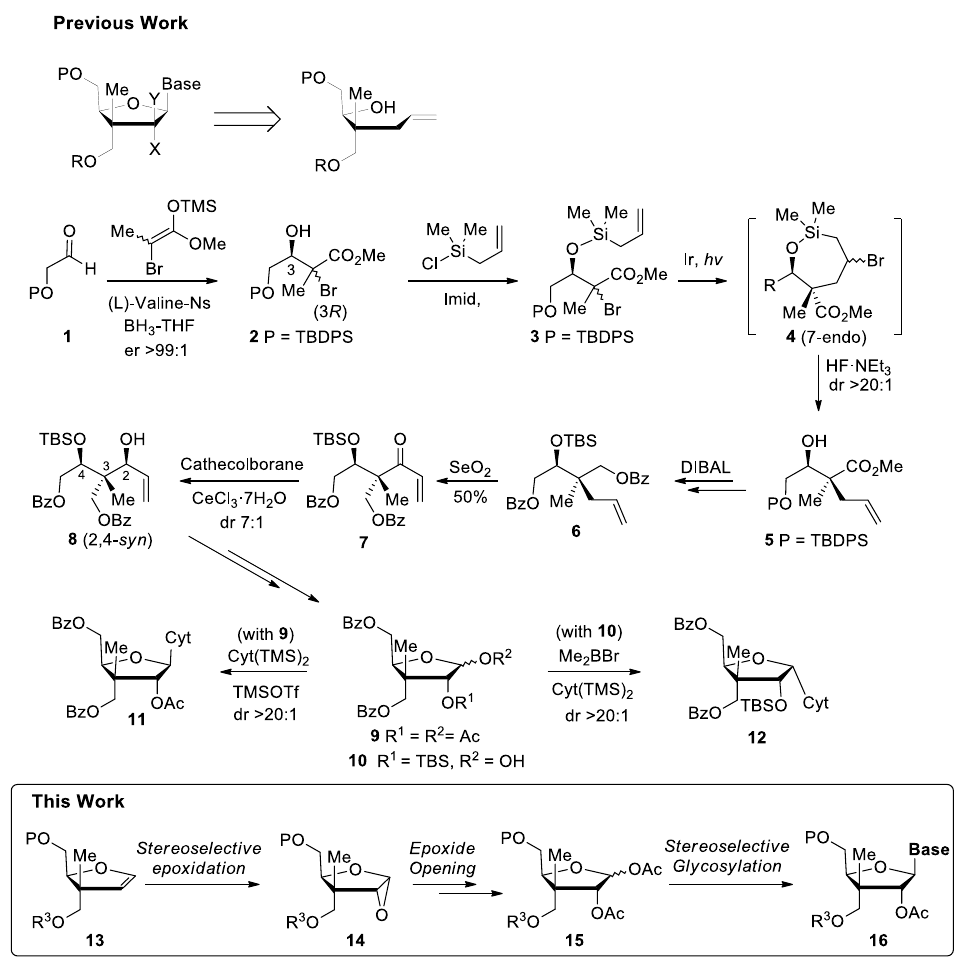
Figure 2. Novel nucleoside analogues bearing a quaternary stereocenter at C 3′ .